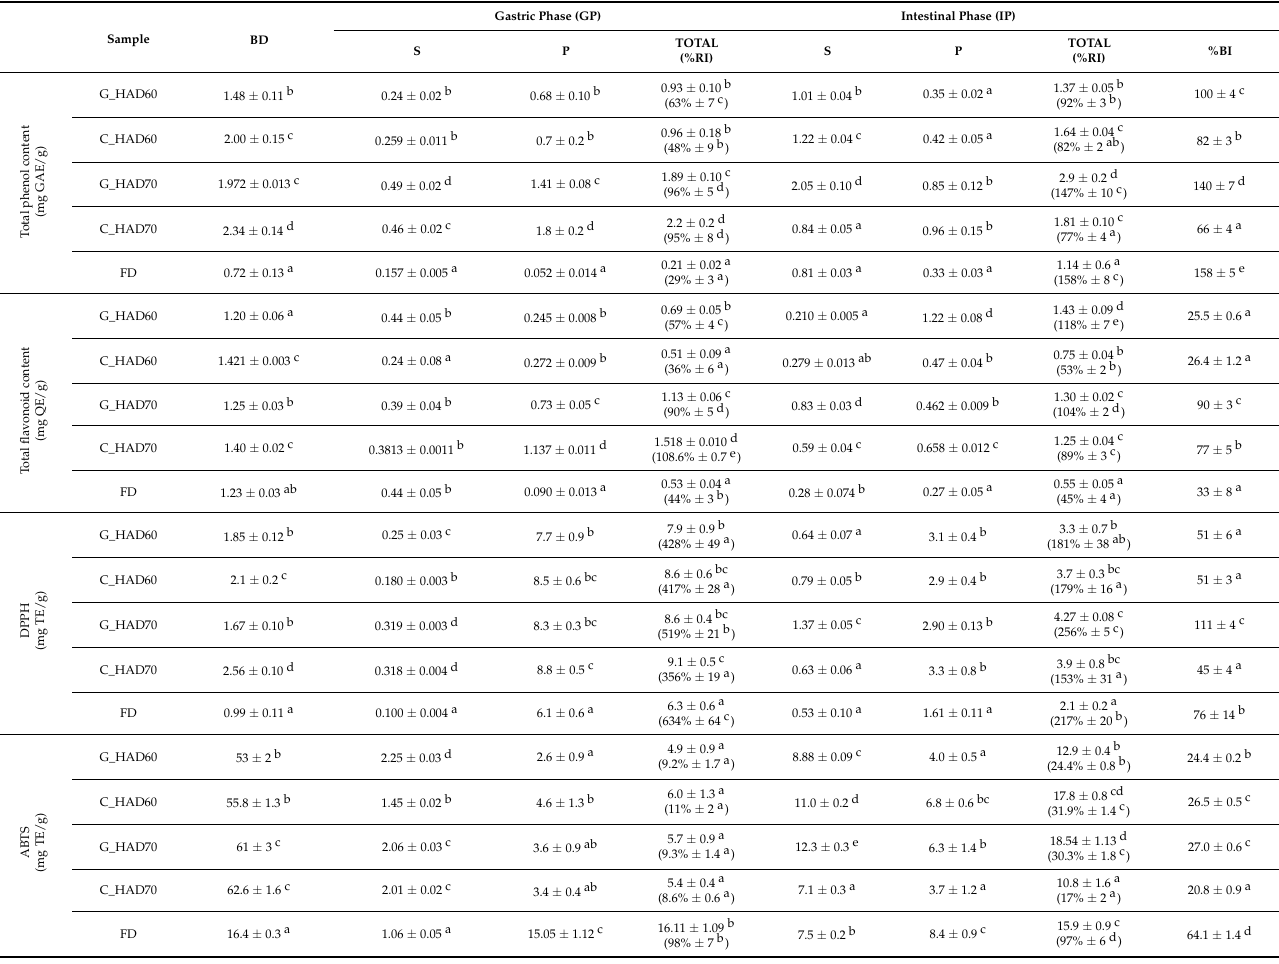
Table 5. Total phenol content, total flavonoid content and antioxidant capacity (DPPH and ABTS) of carrot waste powders before digestion (BD), after the gastric phase (GP) in the supernatant (S) and precipitate (P), and after the intestinal phase (IP) in the supernatant (S) and precipitate (P) of the in vitro digestion process. Results are given per gram of non-digested sample. Recovery (RI) and bioaccesibility (BI) indexes are expressed in percentage. Mean ± standard deviation of three